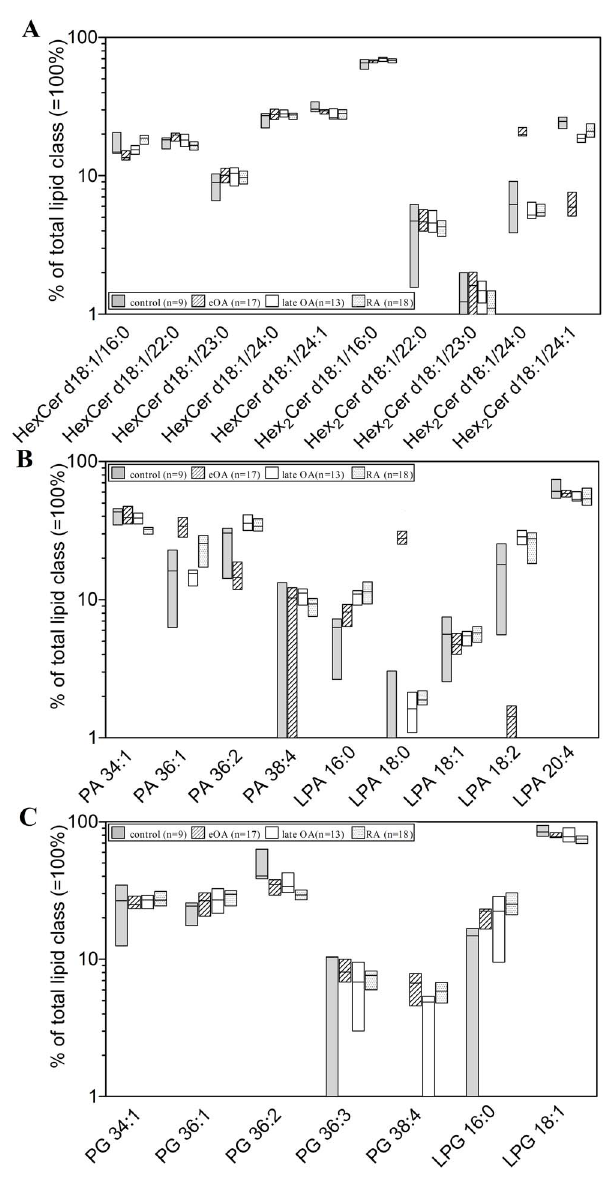
Figure 4. Relative distribution of HexCer and Hex 2 Cer, PA, LPA, PG and LPG species in in human knee synovial fluid. Synovial fluid was obtained from donors serving as controls and from patients with early osteoarthritis (eOA), late OA (lOA), and rheumatoid arthritis (RA). The data show the percentage of the lipid species from the total corresponding lipid class (=100%). Values are presented as median and interquartile range. ( A ): HexCer and Hex 2 Cer species, ( B ): PA and LPA species, ( C ): PG and LPG species. HexCer- hexosylceramide (most likely glucosylceramide), Hex 2 Cer- dihexosylceramide (most likely lactosylcer- amide), PA- phosphatidic acid, LPA- lysophosphatidic acid, PG- phosphatidylglycerol, LPG- lysophosphatidylglycerol. doi:10.1371/journal.pone.0091769.g004 36:2 with concentrations between 0.062 and 3.07 pmol/ml; Figure 6). Five PG and 2 LPG (LPG 16:0 and LPG 18:1) species were found in human SF at concentrations of 0.1–5.0 pmol/ml (Figure 6). Notably, in comparison with control SF, the levels of all PG and LPG species were elevated by 3.5-fold (2.5–5.6-fold; p # 0.01) in eOA, 3.6-fold (2.8–4.6; p # 0.05) in lOA, and in RA SF